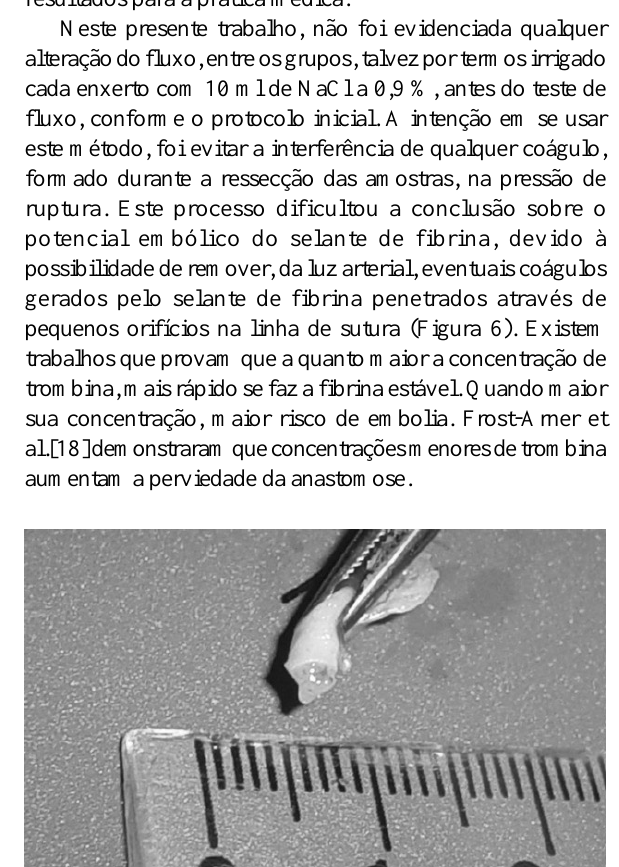
1. Braunwald NS, Gay W, Tatooles CJ. Evaluation of crosslinked gelatin as a tissue adhesive and hemostatic agent: an experimental study. Surgery. 1966;59(6):1024-30. 2. Souza C. Uso de adesivos biológicos em anastomoses intestinais. Estudo experimental em coelhos [Tese]. Belo Horizonte:Faculdade de Medicina da UFMG;1993. 3. Schenk WG 3rd, Goldthwaite CA Jr, Burks S, Spotnitz WD. Fibrin sealant facilitates hesmostasis in arteriovenous polytetrafluoroethylene grafts for renal dialysis access. Am Surg. 2002;68(8):728-32.